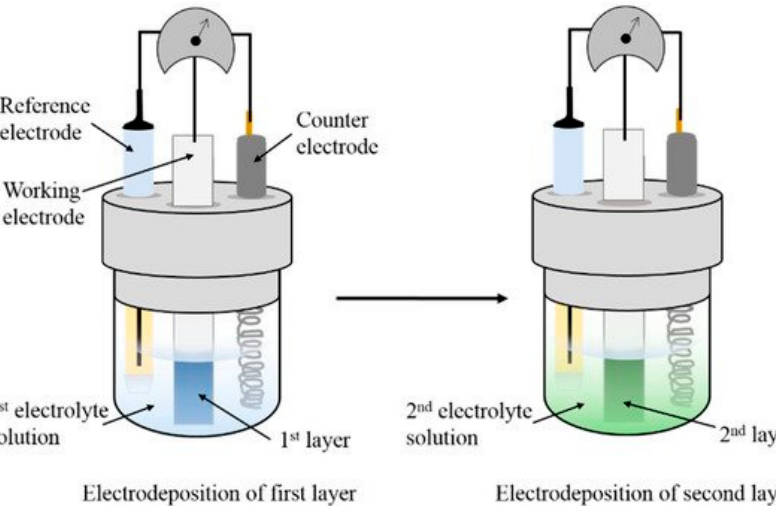
Figure 4. Sketch of the simpler procedure for the fabrication by electrodeposition of LbL materials. Reprinted from Kulandaivalu et al. [42] , with permission under Open access CC BY 4.0 license,